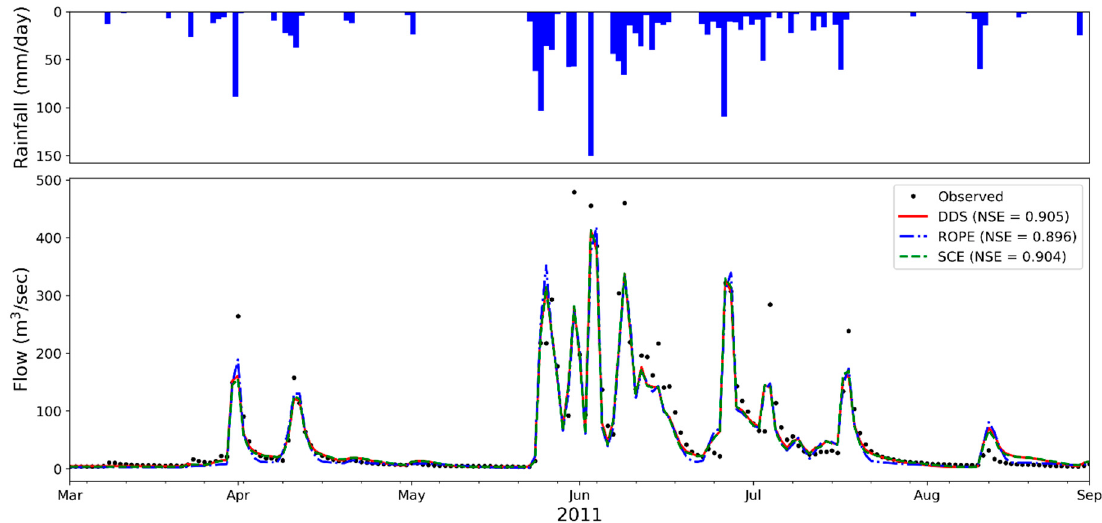
Figure 9. Comparison of calibrated results using the three optimization algorithms with their performance measure of NSE values at Station 1002640.